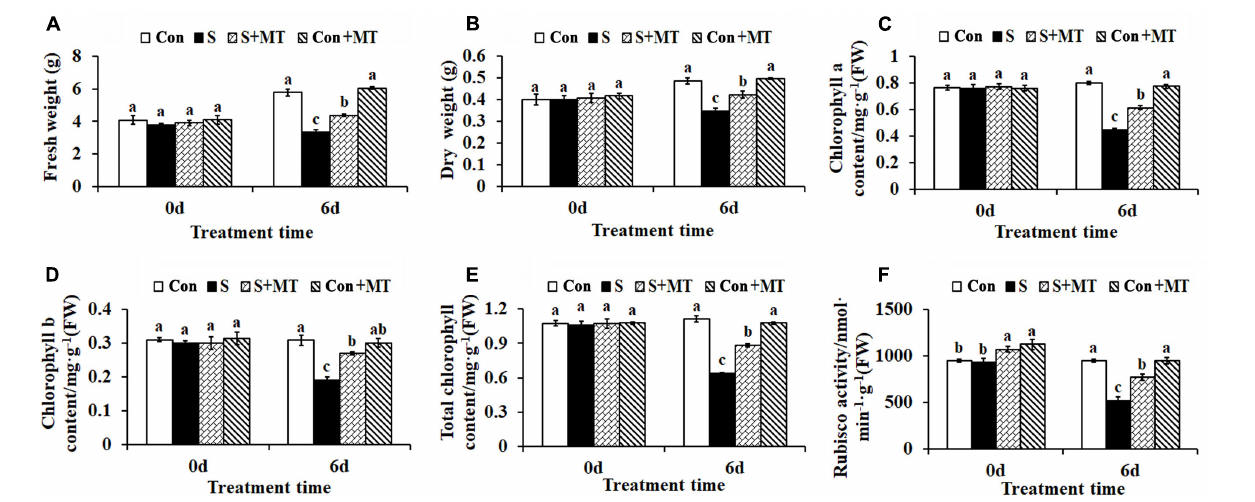
FIGURE 2 | Effects of melatonin on chrysanthemum seedling growth, chlorophyll content and Rubisco enzyme activity under heat stress. (A) Fresh weight. (B) Dry weight. (C) Chlorophyll a. (D) Chlorophyll b. (E) Total chlorophyll. (F) Rubisco activity. Con, control; S, heat stress; S + MT, heat stress with exogenous melatonin treatment; Con + MT, control with exogenous melatonin treatment. Error bars indicate SE ( n = 3). Duncan’s multiple range test was used to analyze significant differences. Different letters indicate significant differences at P <